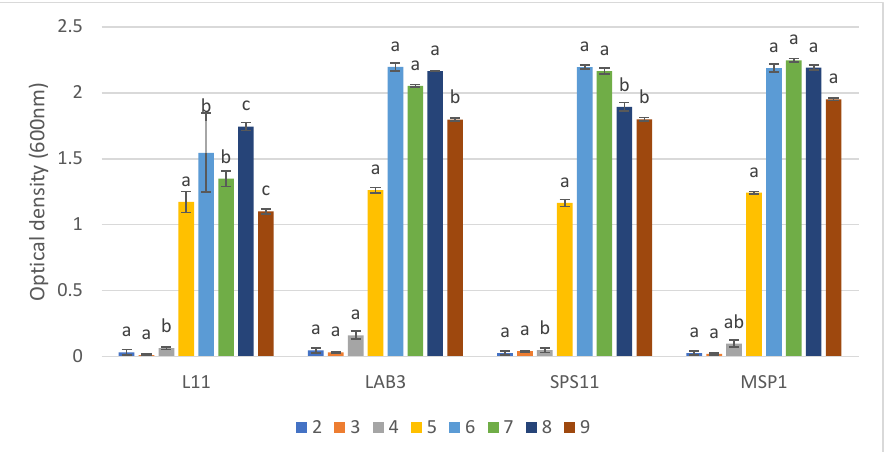
Figure 5. The growth of MSP1 and its constituent single-strain probiotics (SSPs) at different pH levels (2 – 9). Values are presented as mean ± SE ( n = 3). Significant differences are indicated by different letters ( p < 0.05).